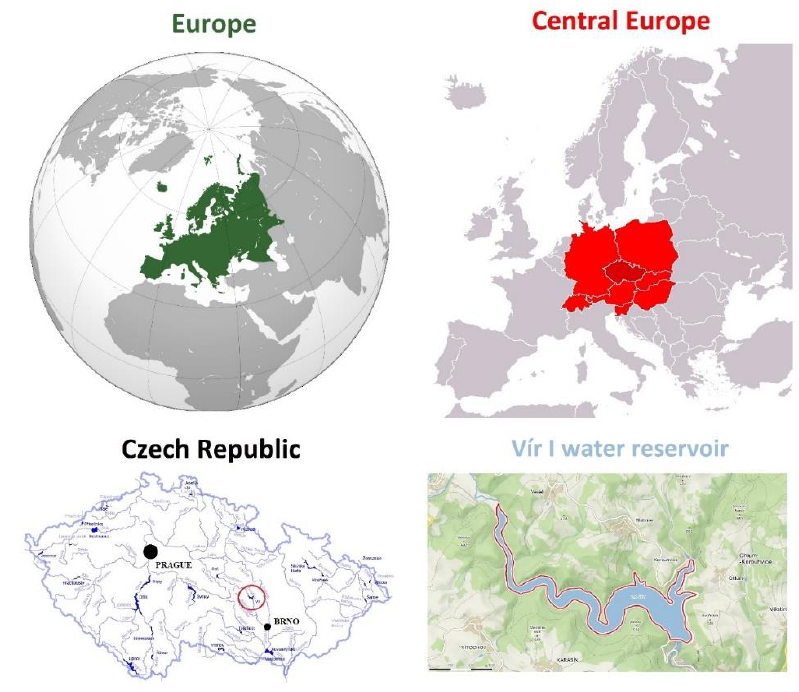
Figure 1. Location of the Vír I water reservoir.